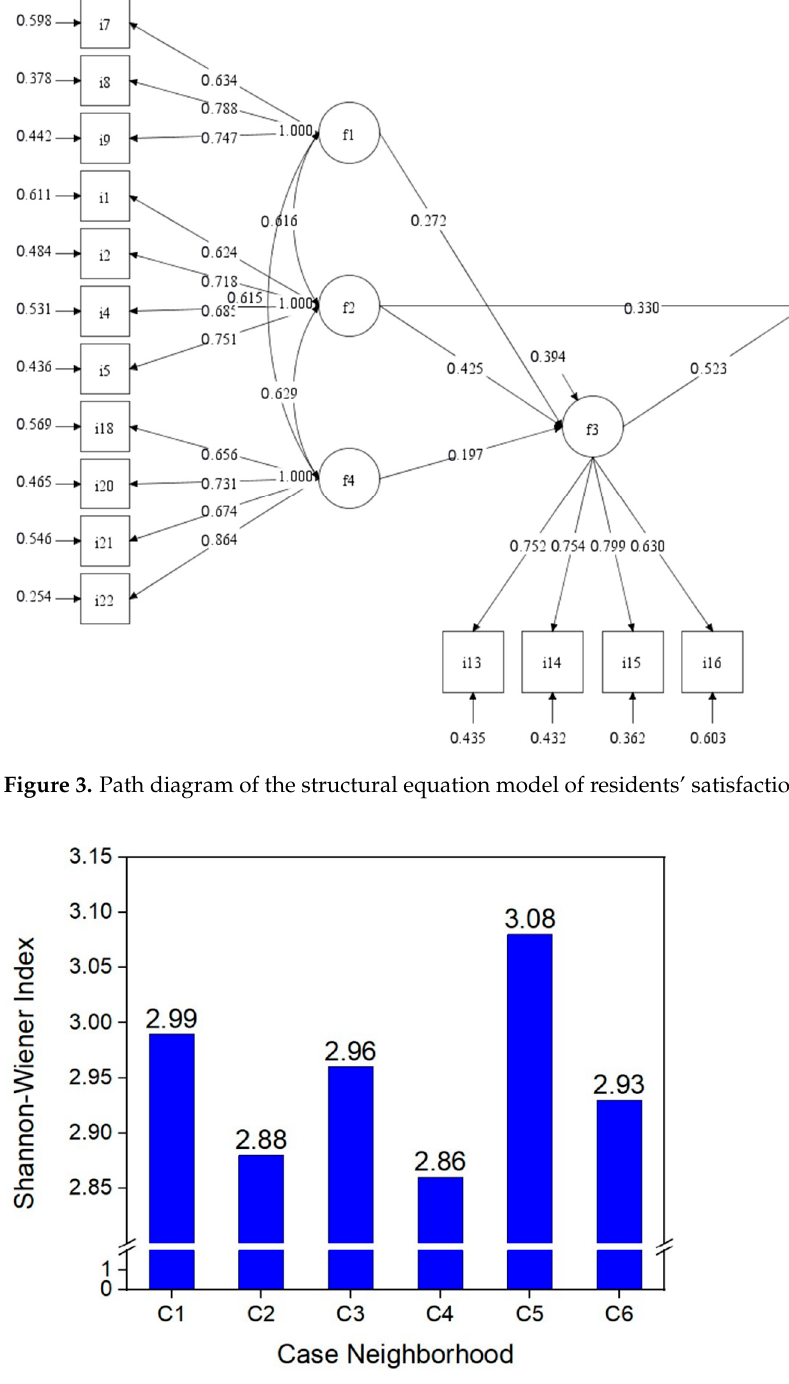
Figure 5. Structure of green quantity of the six case neighborhoods. Figure 6 shows the colors and landscape types. Case neighborhoods C4 and C5 have a greater number of colors and landscape types than the other case neighborhoods, while C1 and C2 have the lowest number of colors, and C1 is the case neighborhood that has the lowest number of landscape types. The complexity of landscape components characteriz- ing landscape diversity is also shown in Figure 6. C1 has the lowest complexity of land- scape components, while both C4 and C5 have much higher complexity than the other case neighborhoods, which is approximately six to seven times that of C1. Figure 7 shows the building density and crowdedness of building space. Both building density and build- ing space crowdedness of C3, C4, and C6 are relatively high, while they are relatively low in C2 and C5, indicating a better condition of landscape openness in C2 and C5.